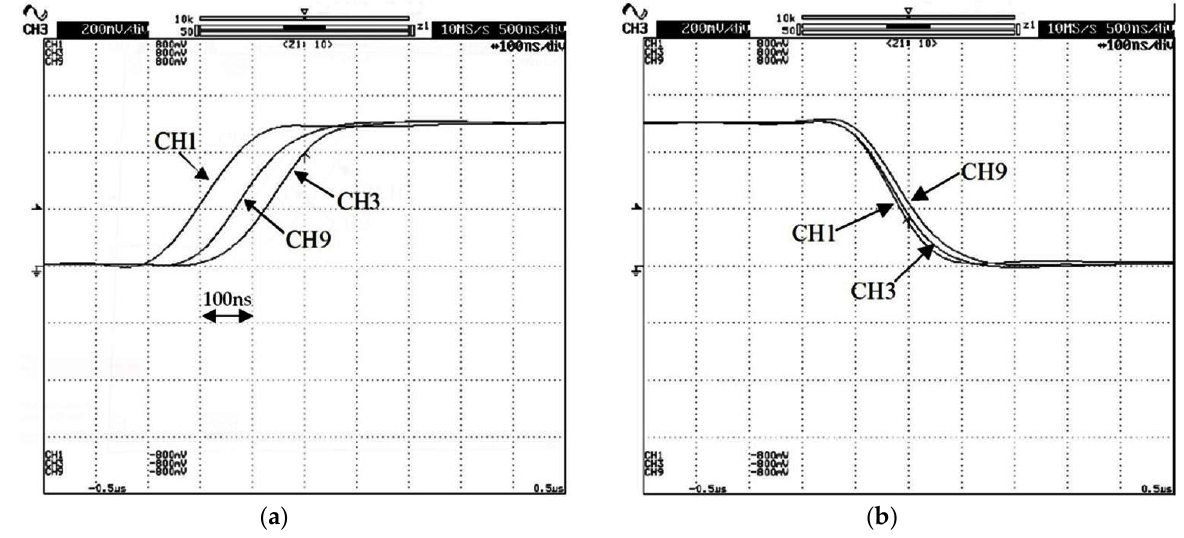
Figure 4. Control signals for three inverter legs measured after the optical transmission [16]: ( a ) rising edge—light off; ( b ) falling edge—light on [ 9].